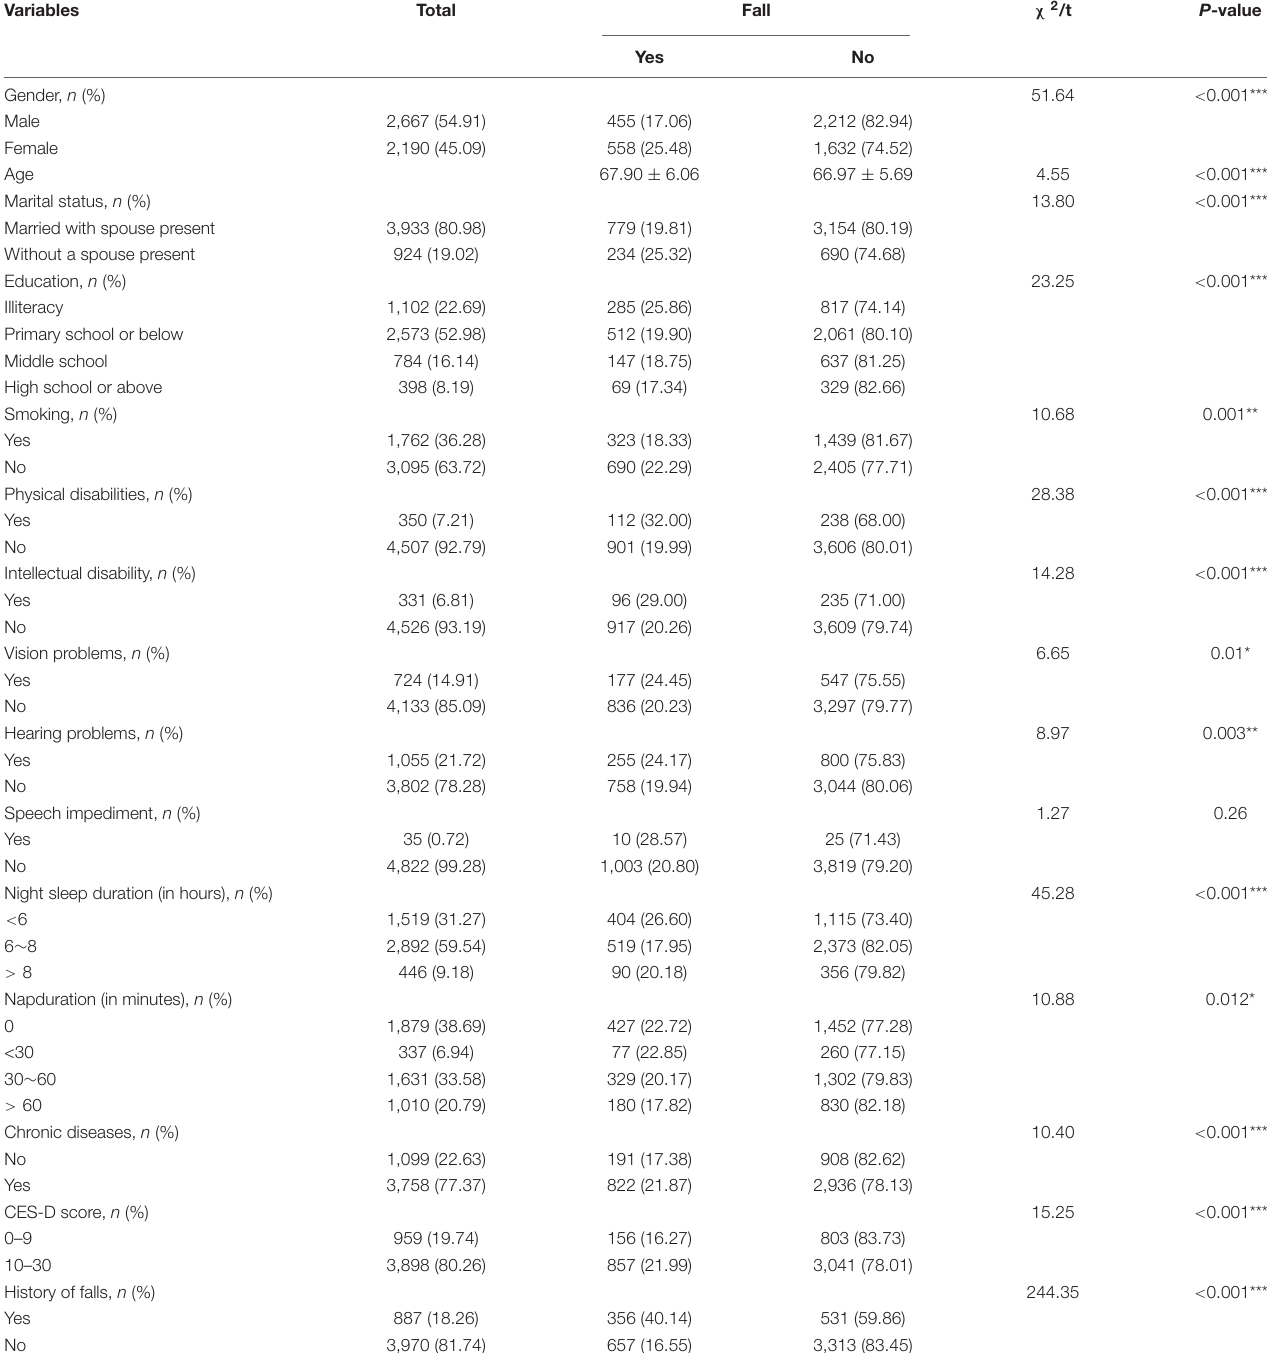
TABLE 1 | Comparison of general characteristics between the falls and no falls group ( n = 4,857).